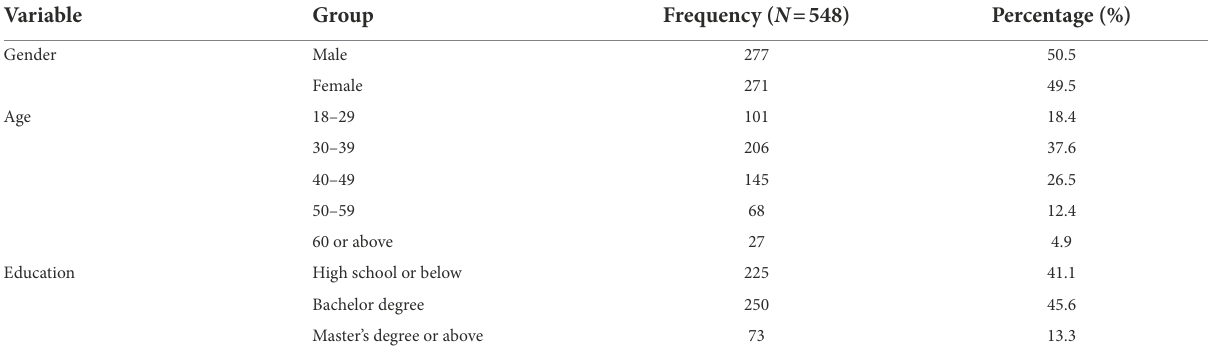
TABLE 1 Main characteristics of survey